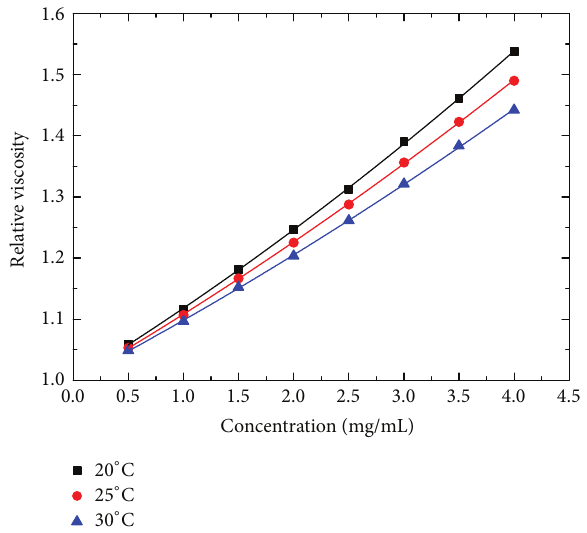
Figure 1: Relative viscosity of the PEOX 500,000 aqueous solutions at different concentrations and temperatures.